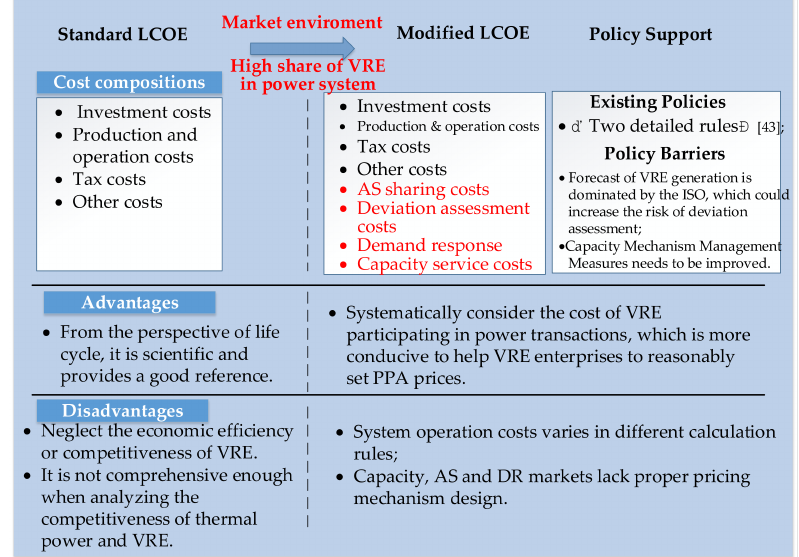
Figure 4. Comparisons of the standard LCOE and the modified LCOE